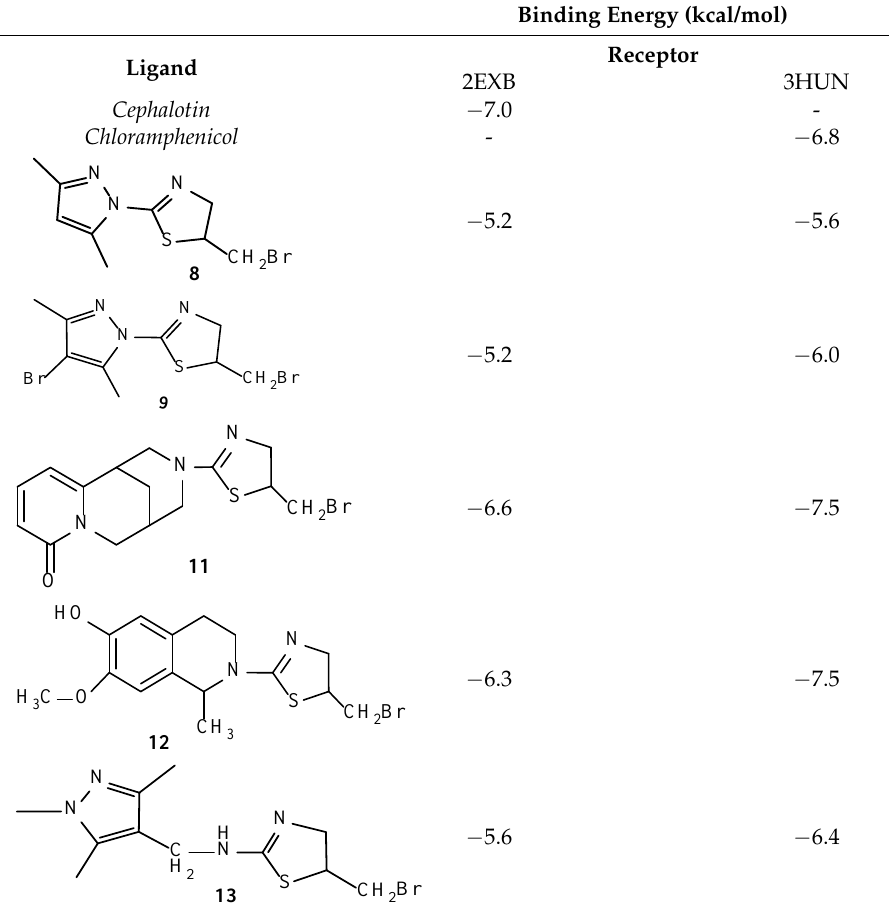
Table 1. Binding affinity (kcal/mol) of 1,3-thiazoline derivatives with active sites of penicillin binding Analysis of the interactions of 2EXB and 3HUN protein complexes with ligands 8, 9, proteins 4 (PBP4) E. coli “Homo sapiens” (PDB: 2EXB) and S. Aureus (PDB: 11 – 13 showed that all the studied derivatives formed sufficiently strong complexes with the target receptor protein (Table 1).